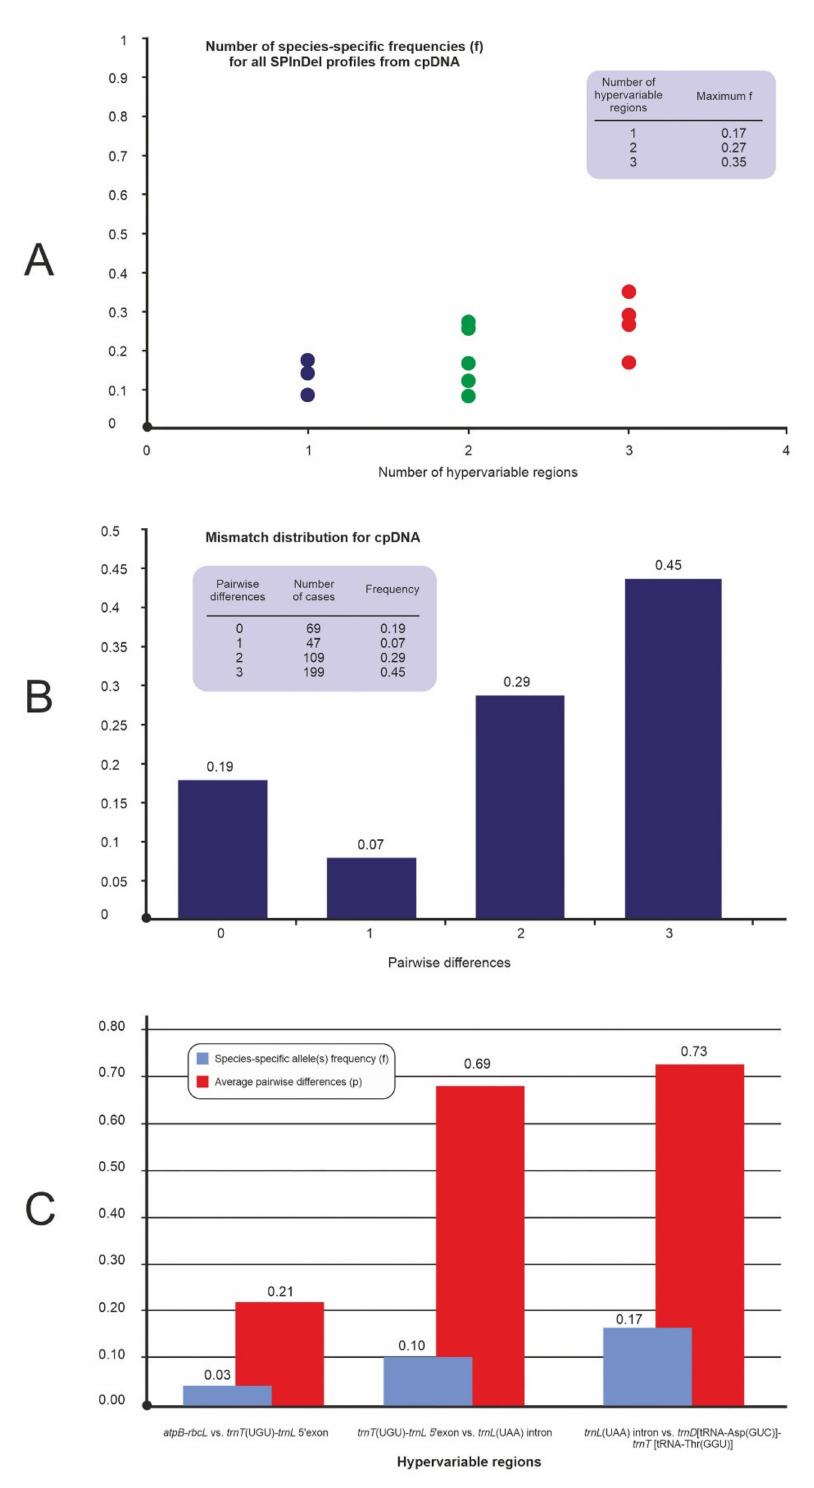
Figure 2. SPInDel analysis of 4 cpDNA variable-length sequences ; ( A ) The frequency of species-specific profiles in all combinations of hypervariable cpDNA regions; ( B ) Mismatch distribution, i.e., the frequency distribution of the number of SPInDel hypervariable cpDNA regions that differ between all pairs of SPInDel profiles in a taxonomic group; ( C ) The discriminatory potential of each hypervariable cpDNA region individually (region by region